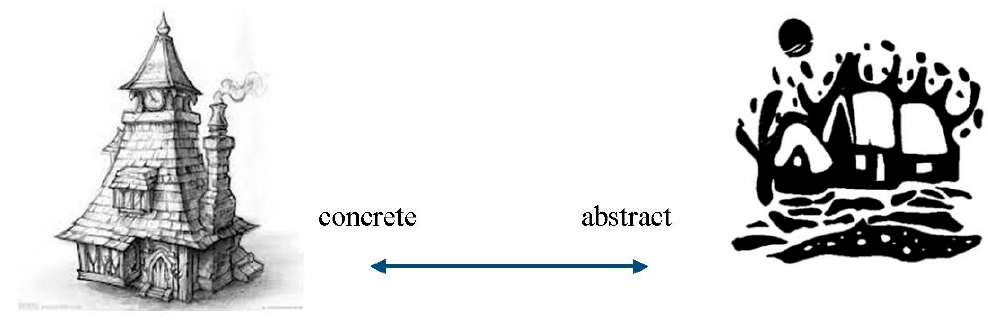
Figure 6. Different types of art.